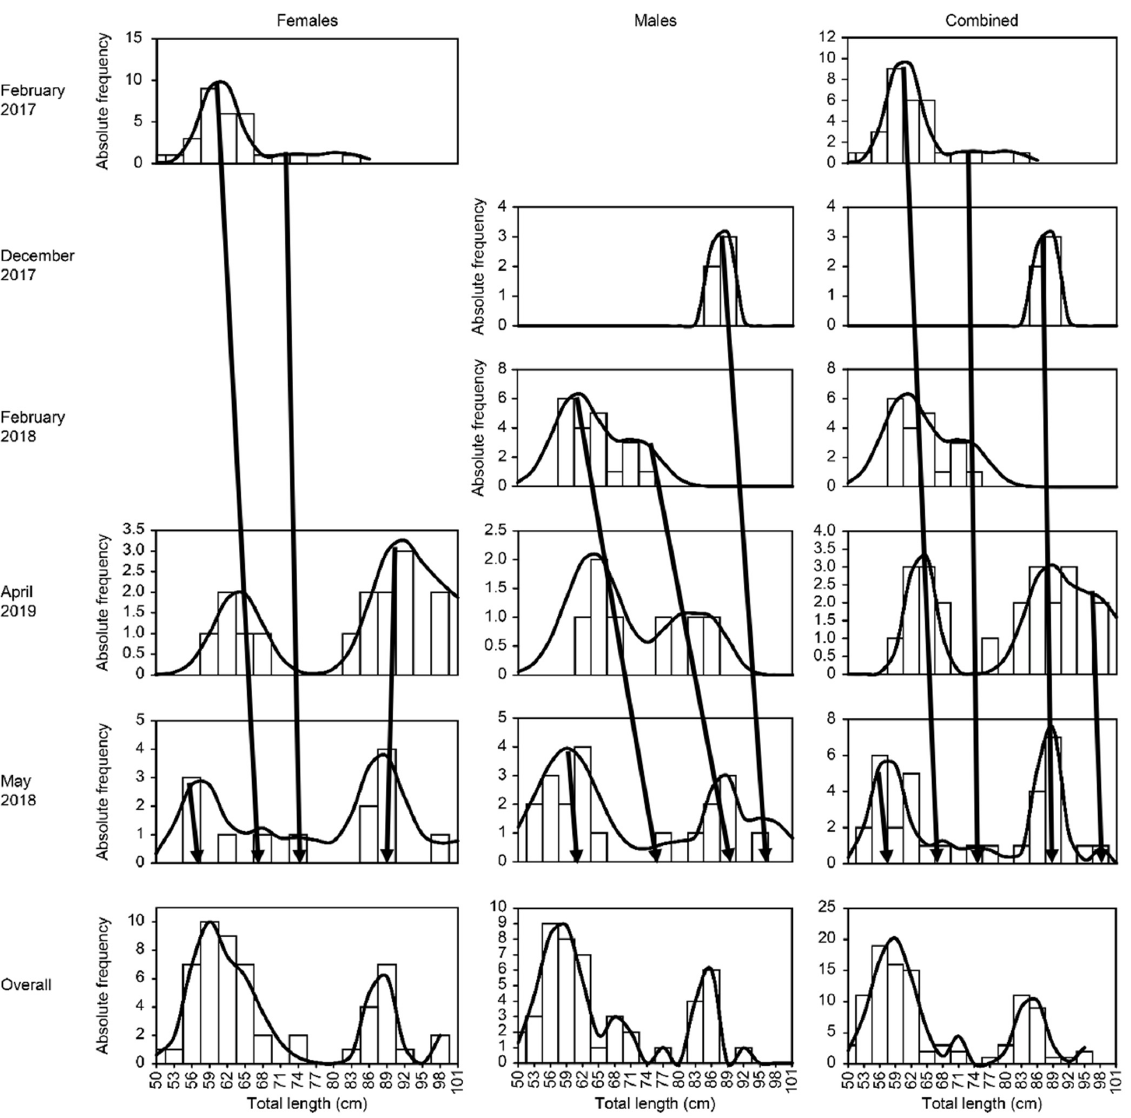
Figure 2. Size frequency distribution (bars) and modal groups (lines) estimated for the bonnethead shark ( Sphyrna tiburo ) in the western Gulf of Mexico. (The months of the year are sorted sequentially without considering the year). Table 3. Values of the maximum likelihood, the information criterion, and the specific weight of each candidate model, contributing to the description of growth patterns in females, males, and combined sexes of the bonnethead shark ( Sphyrna tiburo ) in the western Gulf of Mexico, under additive and multiplicative errors.